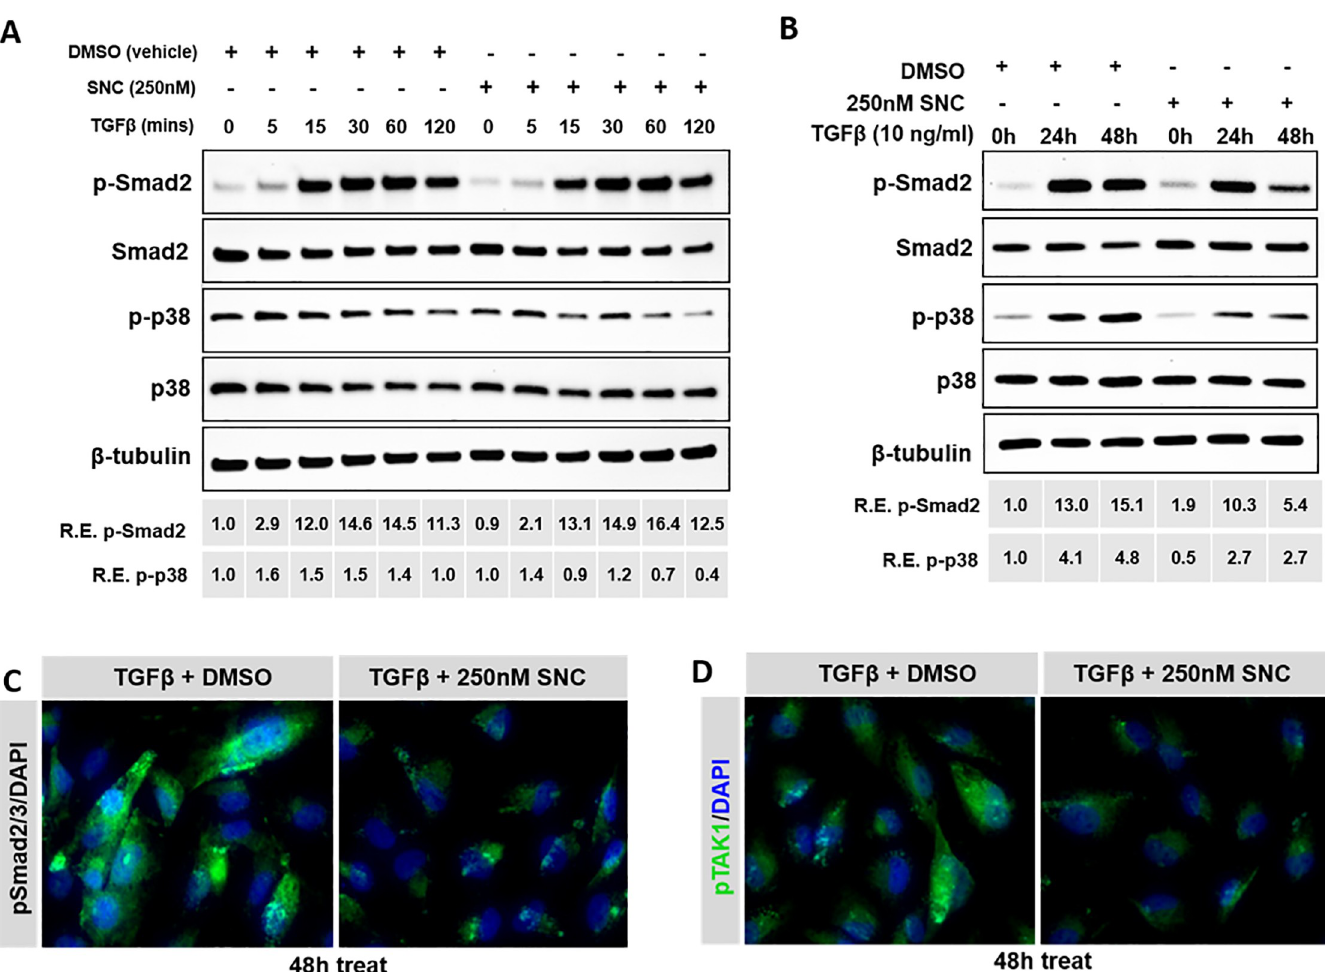
Fig 6. SNC targets both the p38 and pSmad2 pathways upon TGF β stimulation. ARPE-19 cells were pre-treated with 250nM SNC for 1 hour before TGF β was added. Western blotting of protein samples collected from early (A) and later (B) time-points of TGF β stimulation were analyzed. We find that pSmad2 levels are not initially effected by SNC treatment, but p-p38 levels are lower. By 24 hours, we begin to see differences in pSmad2 levels, which persist at 48 hours, showing that SNC indirectly targets Smad2 signaling. Immunofluorescence staining of ARPE-19 cells after 48 hours of TGF β /SNC show that both pSmad2/3 (C) and pTAK1 (D) expression is